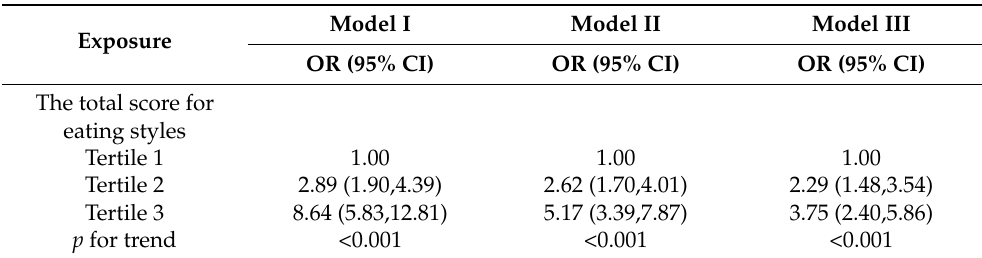
Table 3. Association between the total score for eating styles and irritable bowel syndrome in different models ( n =